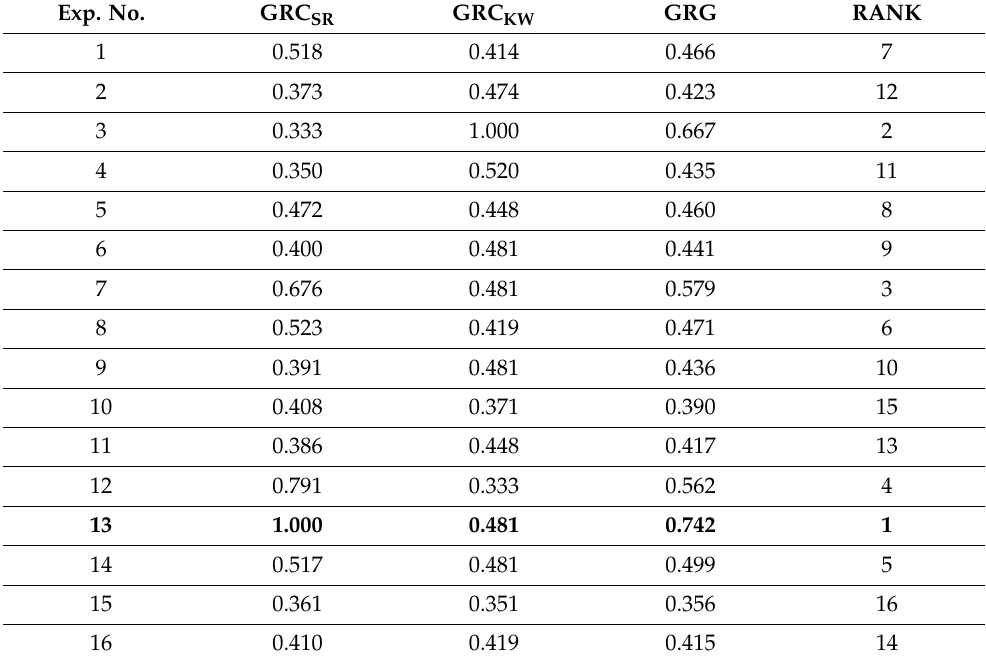
Table 5. Grey relational analysis results. Exp. No. GRC SR GRC